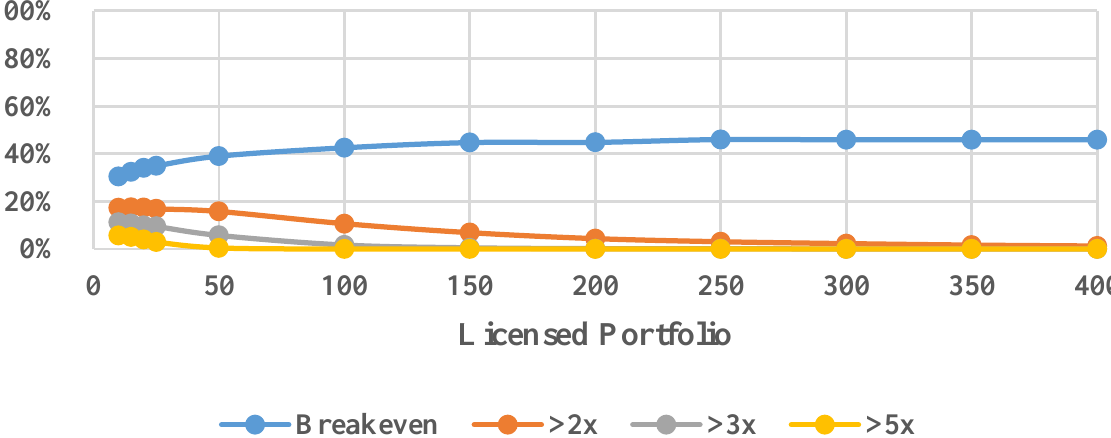
Figure 9. The challenge of breaking even when 20% of the patented portfolio is licensed, and the cost burden of the 80% unlicensed portfolio is included.